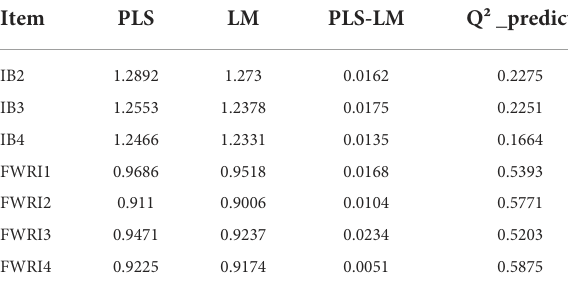
TABLE 6 Partial least squares predict